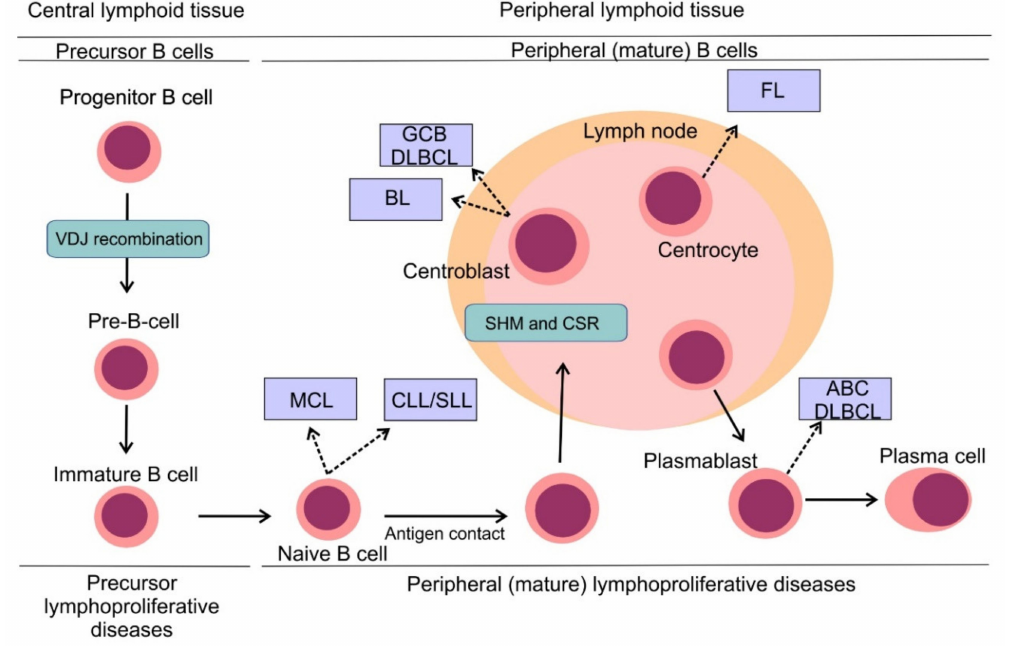
Figure 3. Pathogenesis of B-cell non-Hodgkin lymphomas. Simplified scheme of B cell development showing distinct types of B-NHLs arising from di ff erent non-malignant lymphoid counterparts. Reprinted with permission. © (2020) American Society of Clinical Oncology. All rights